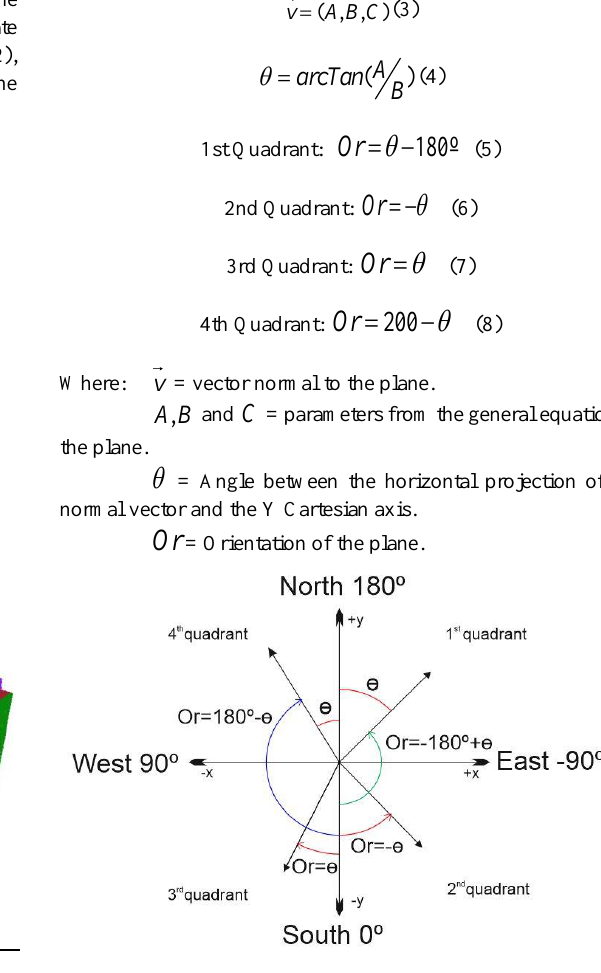
Figure 8: Absolute orientation of the slope from the angle between the projection of the vector v on the horizontal plane and the Y Cartesian axis.